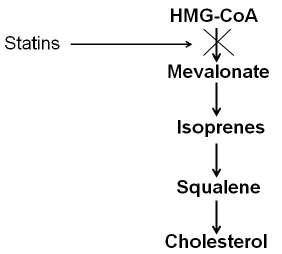
Figure 2. Main stages in the cholesterol biosynthesis pathway.